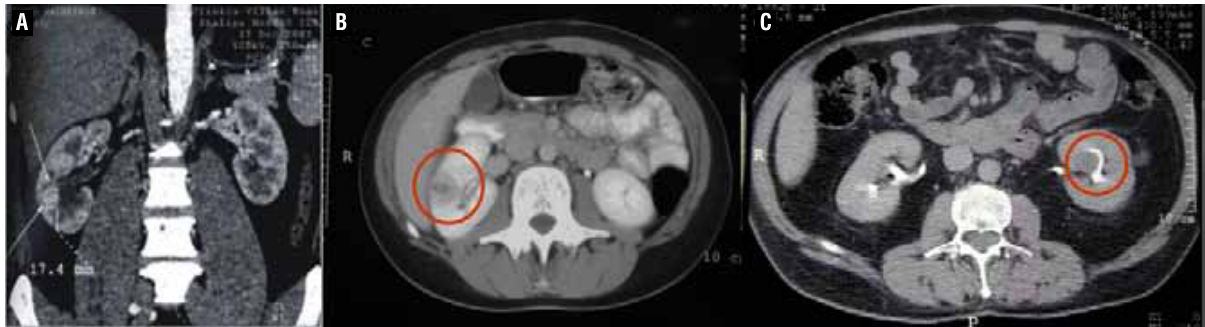
figura 1 - (A-c) Intraparenchymal tumors.